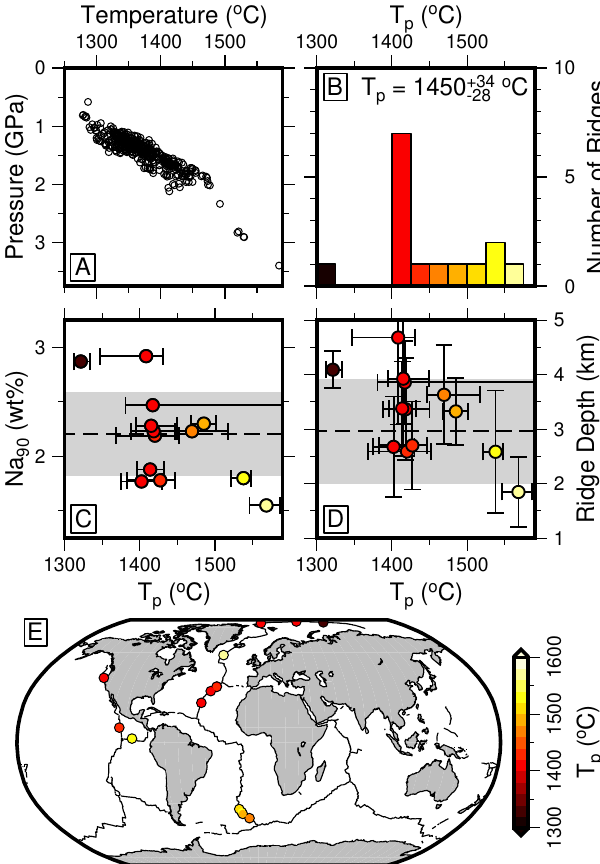
Figure 2: Thermobarometric T p estimates for mid-ocean ridges (MOR). [A] Melt equilibration estimates for all viable MOR sam- ples [Gale et al. 2013]. [B] Histogram of MOR T p estimates for ridge segments with >5 melt equilibration estimates. Average T p and errors shown top left. [C] MOR T p estimates as a func- tion of ridge Na values; dashed line and gray swath show 90 average and standard deviation of global MOR Na database 90 [Gale et al. 2014]. [D] Same as Panel [C] for ridge-depth mea-